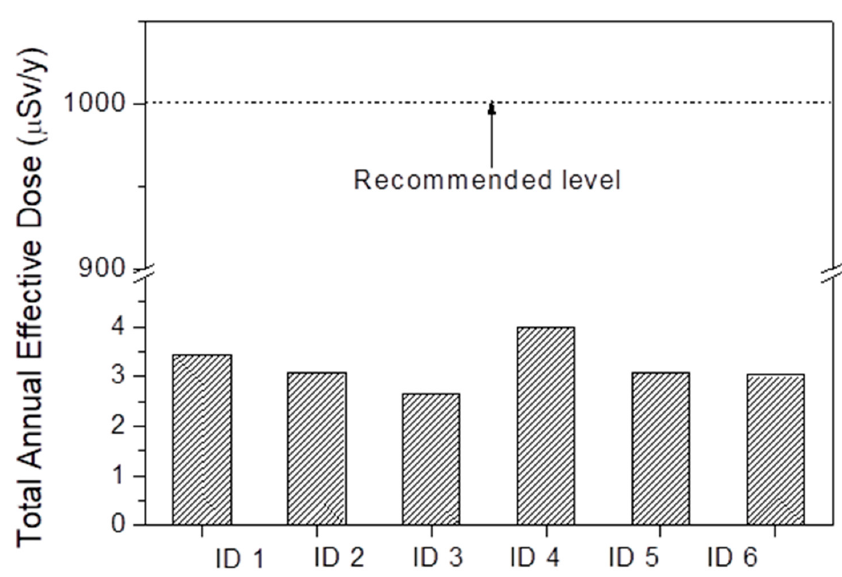
Figure 3. The total e ff ective dose due to sample ingestion by adult members of the population.